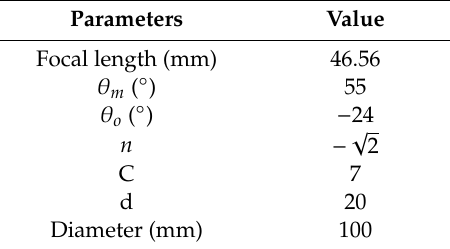
Figure 8. Shaped lens. Table 2. Lens parameters.